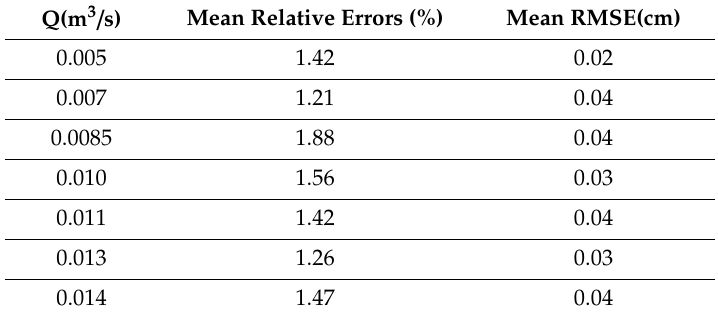
Table 4. Summary of overall mean values of relative errors between numerical and experiment